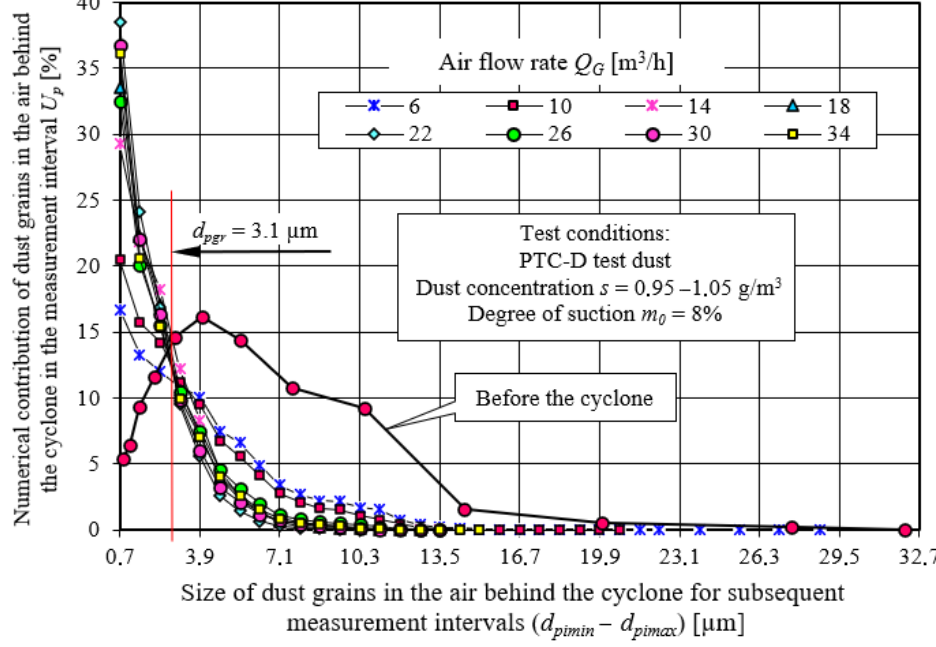
Figure 33. Numerical contributions of U p of dust grains in the air upstream and downstream of the tested cyclone D -40 (No. 1—original version) for different values of air flow Q G .